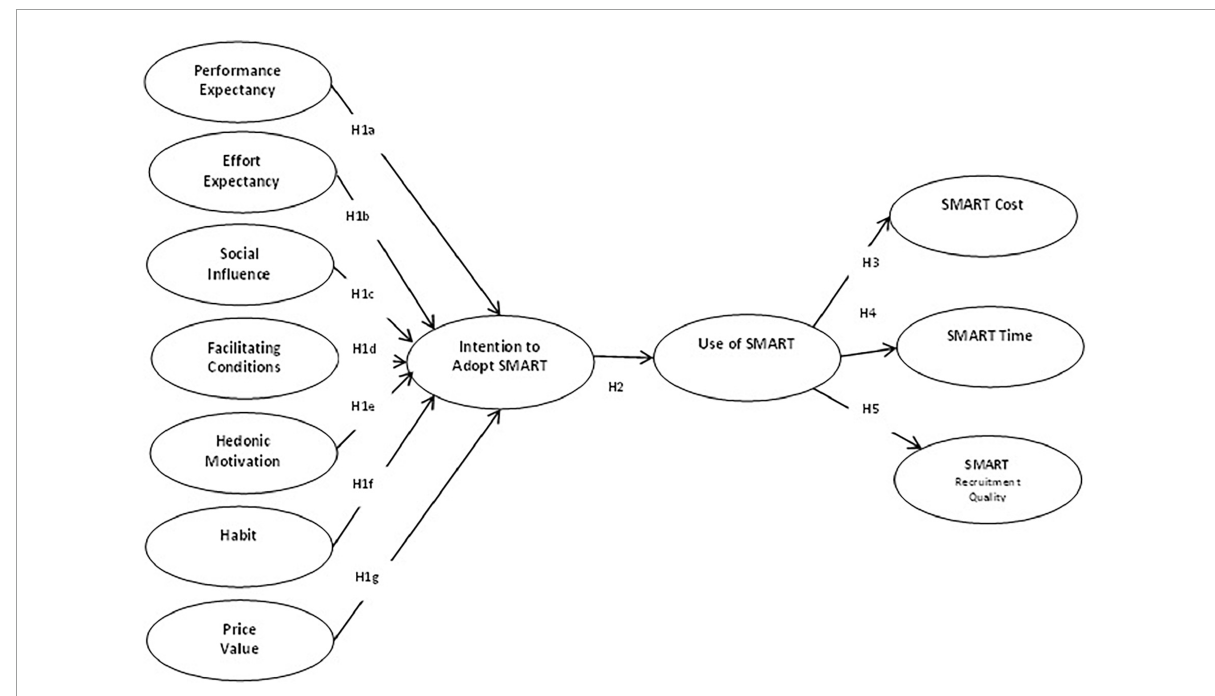
FIGURE1 Research model and proposed